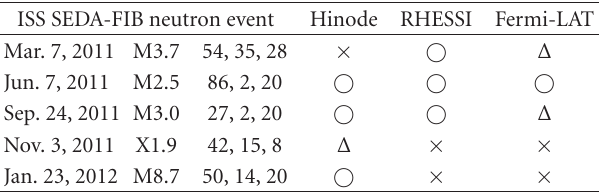
Table 2: A score table between each satellite. The numbers of solar neutron events, from first to third, represent protons induced by neutrons, the incidents of which are consistent with those coming from the Sun, low-energy events di ffi cult to identify as solar neutrons and ambiguous events due to low energy respectively. The marks (cid:3) , Δ , and × imply that each satellite was passing over the day side ( (cid:3) ), partial day side ( Δ ) or night side ( × ) of Earth, respectively. The event observed on September 8, 2011, was not involved in this table, because it was observed near the